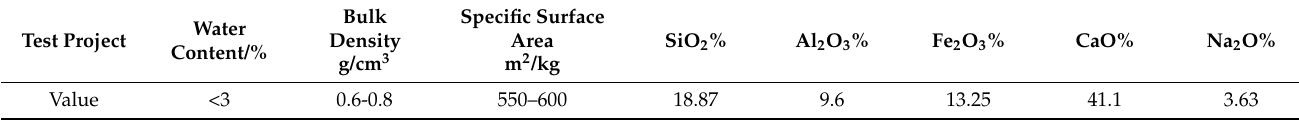
Table 3. The properties of sintered red mud.